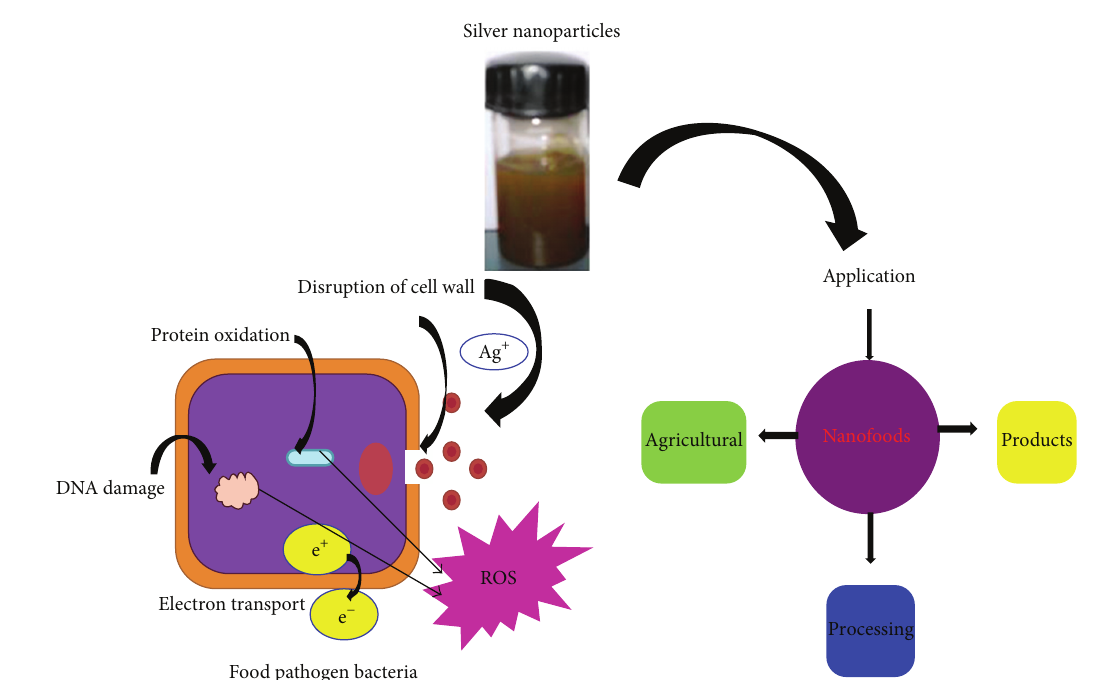
Figure 10: Mechanism of antibacterial activity of SNPs against food borne